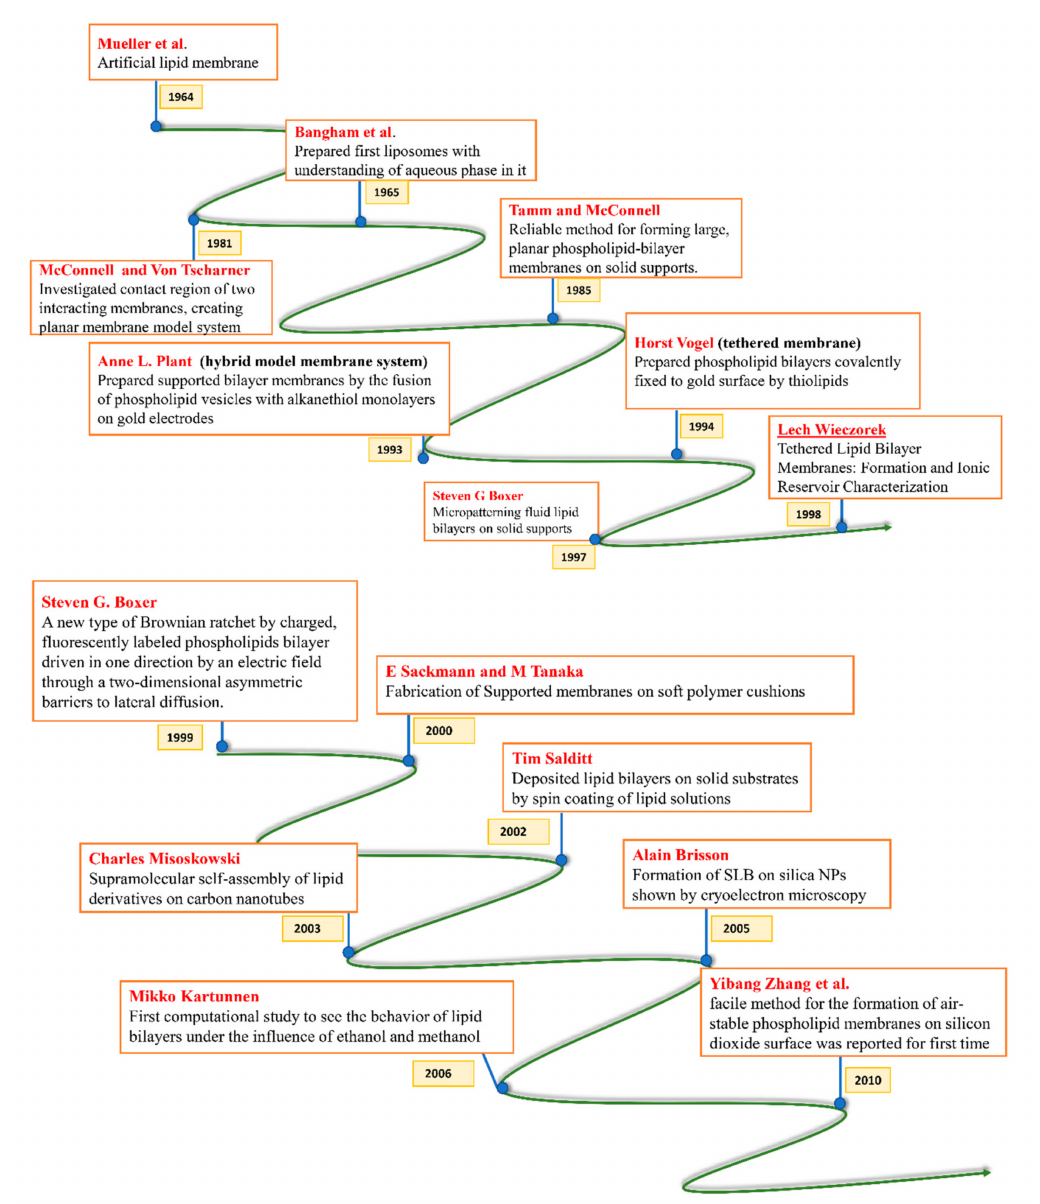
Figure 1. Timeline showing many of the important e ff orts to mimic the biological cell